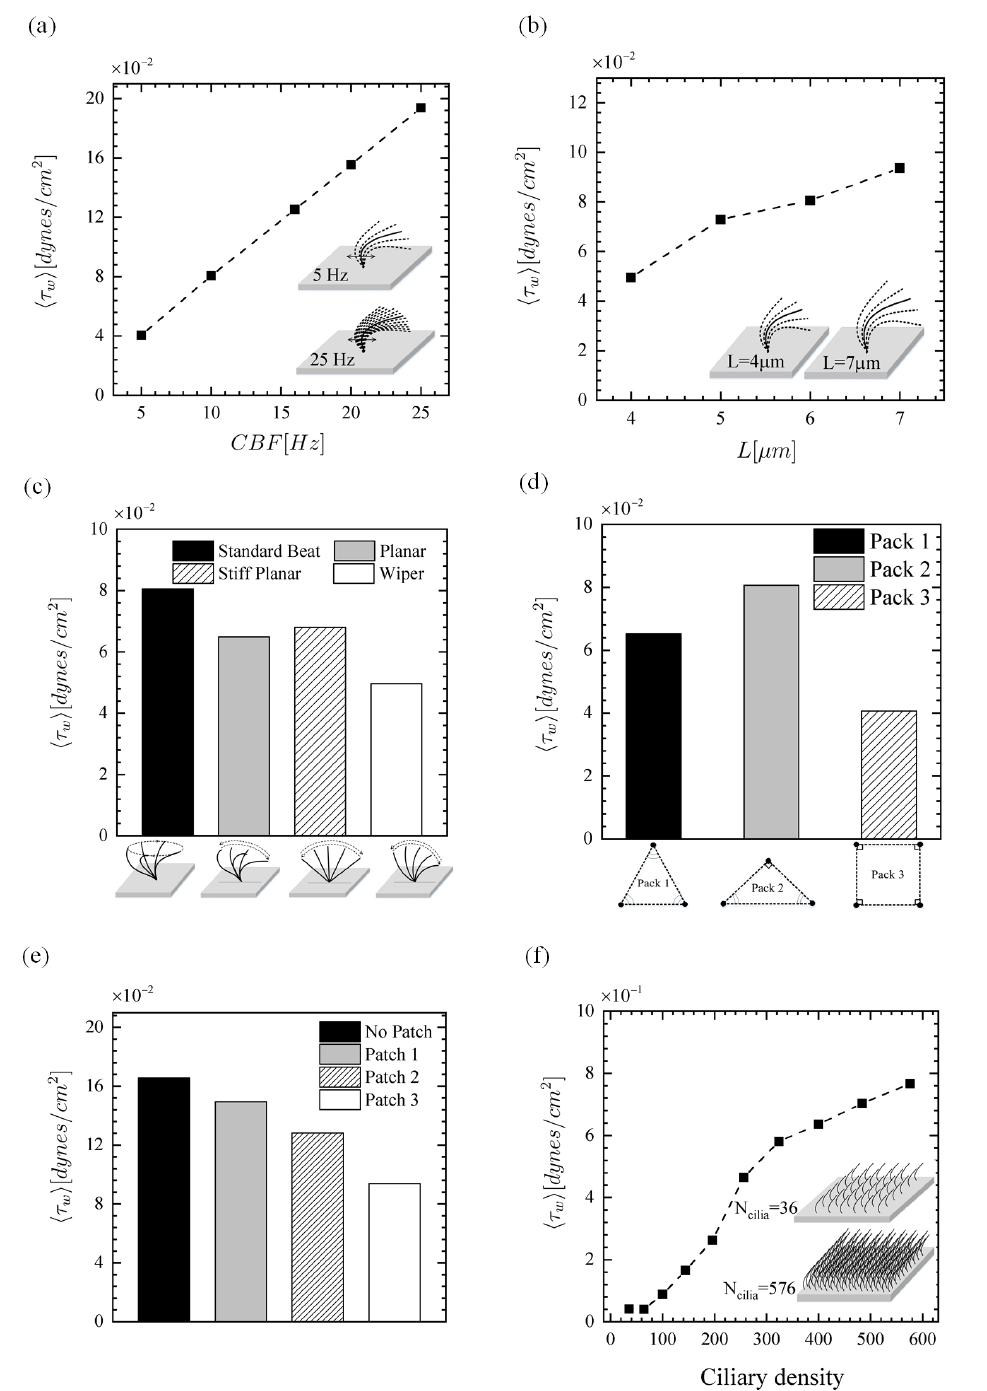
Figure 11. Time-averaged wall shear stress. Effect of ( a ) beat frequency, ( b ) length of cilia, ( c ) ciliary beat pattern, ( d ) ciliary pack, ( e ) missing ciliary patch, and ( f ) ciliary density (number of cilia over the ciliated